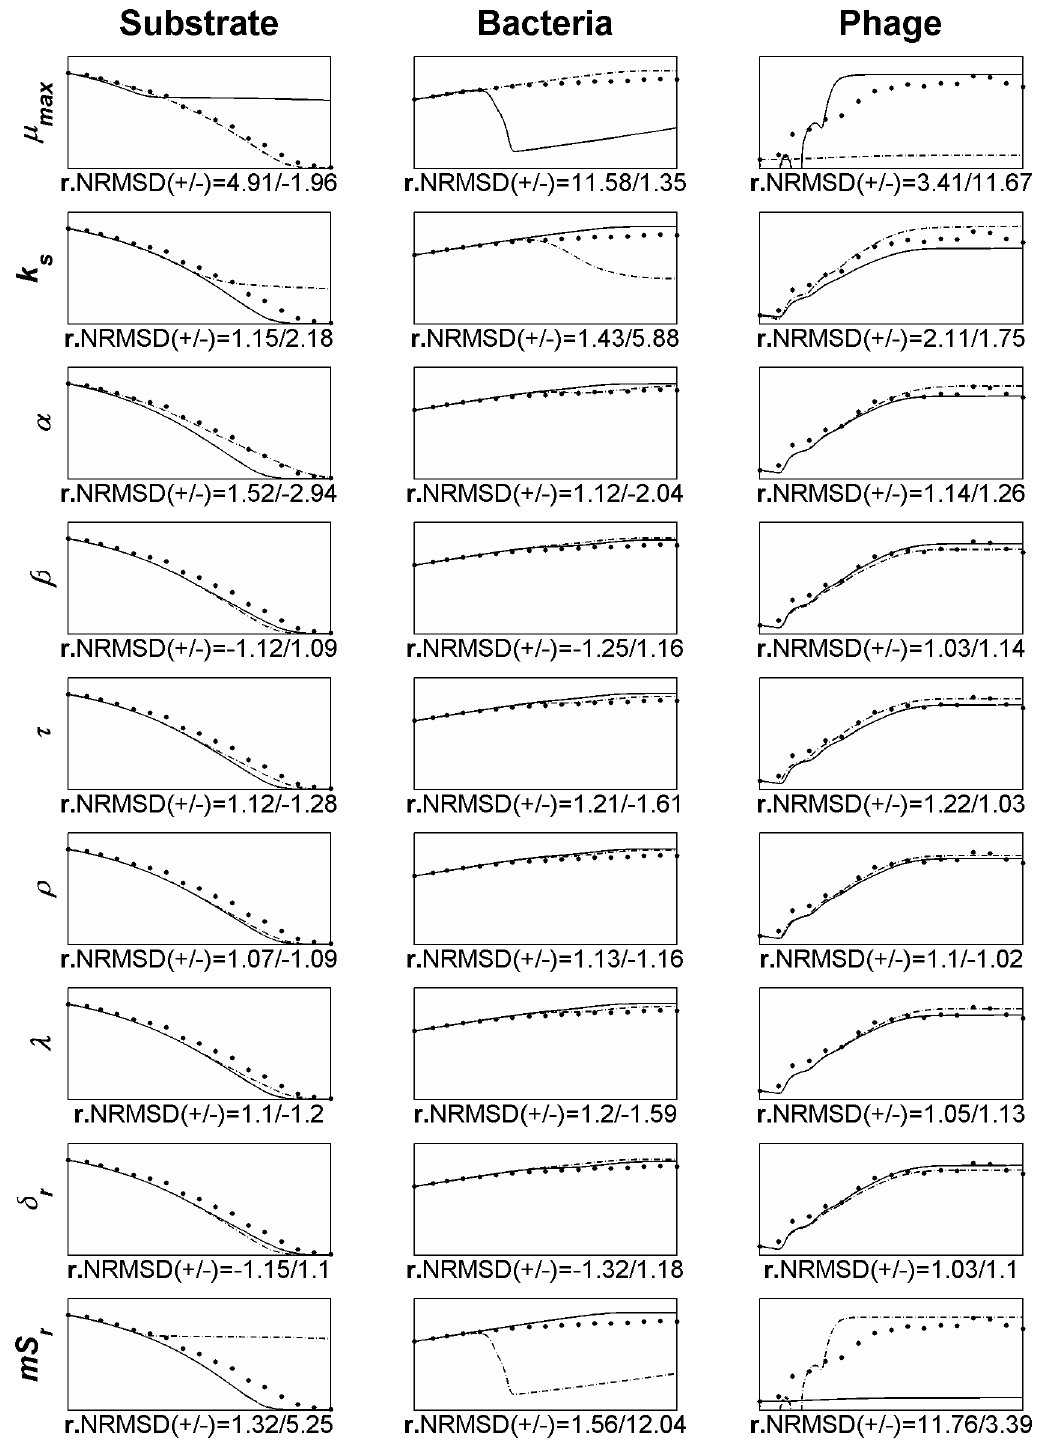
Figure 7. OAT sensitivity analysis of model parameters using as the base-case data from Figure 5. Legend: N experimental data; ___ model simulation when increasing the parameter in 10%; - . - model simulation when decreasing the parameter in 10%. The text on the left side of each line graph identifies the parameter being analysed. m max : maximum rate of exponential growth, K s : half-saturation constant, a : substrate needed for a new bacterium, b : burst size, t : the latent period, r : rise period, l : lambda parameter used in equation 15, d r : experimental determined adsorption rate, mS r : bacterial growth rate at which the adsorption rate was calculated, The x- and y-axis are the same as Figure 5 (x: time [1 8] hours, y Substrate : [0 5000]; y Bacteria : [10 7 10 10 ]; y Phage : [10 5 10 12 ]).